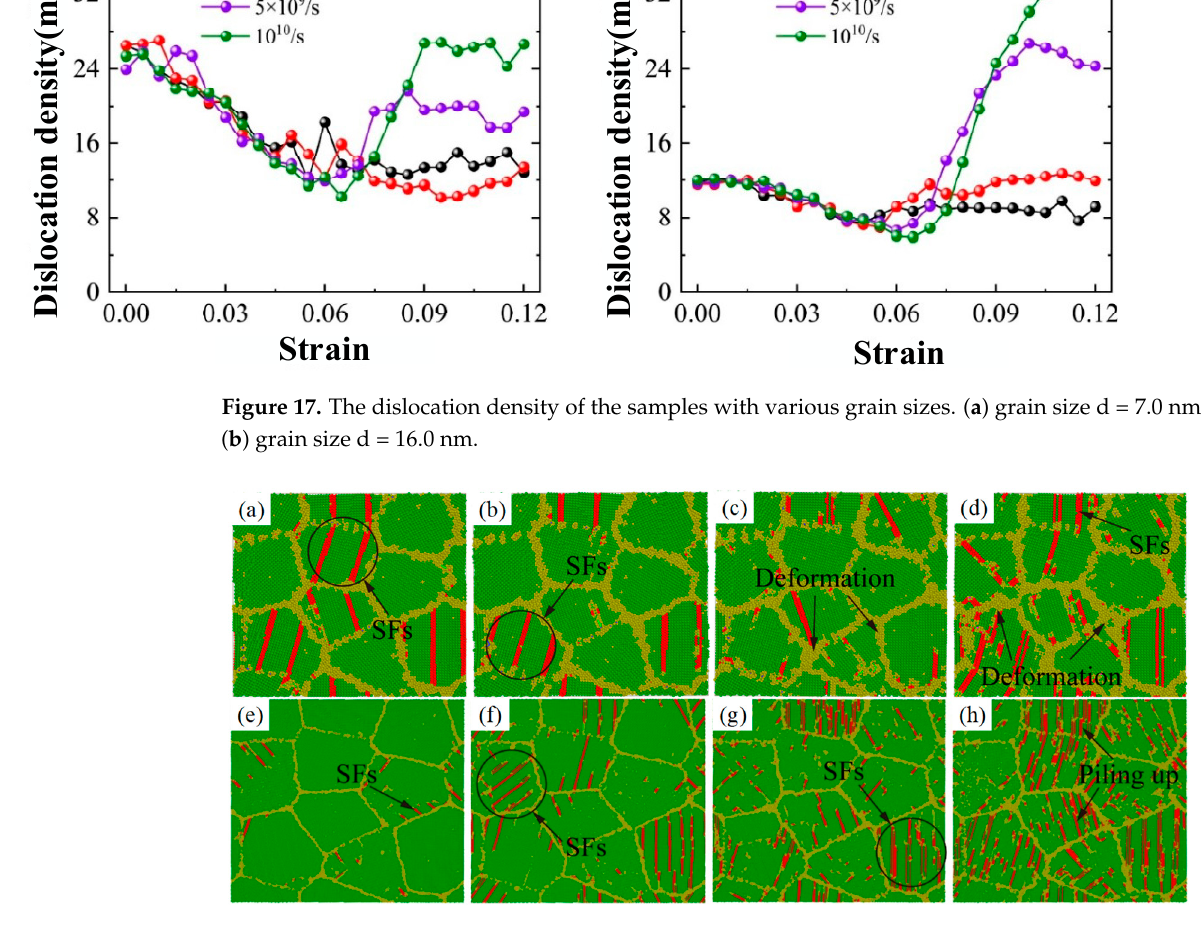
Figure 19. The dislocation lines of the sample with grain size d = 16.0 nm at ε = 12% under different strain rates loading. ( a ) 5 × 10 8 s − 1 , ( b ) 10 9 s − 1 , ( c ) 5 × 10 9 s − 1 , ( d ) 10 10 s − 1 . For polycrystalline Al-Mg alloy model, the yield strength increases with the increas- ing grain size. The proportion of GB atoms influences the dislocation density. The gener- ation of dislocation decreases the yield strength in small grain size. The plastic defor- mation is dominated by grain boundary sliding in the small grain size, while it is domi- nated by dislocation slip in the large grain size. The nucleation and propagation of dislo- cation increase the yield strength at higher strain rate loading process. In addition, the strain rate corresponds to the boundary conditions of the distribution of stress on the spacecraft surface. Large pressure on the surface means a high strain rate of samples. Those results can understand the mechanism of structure failure under hyperthermal pressure condition. 4. Conclusions In summary, the metallic deformation and failure process is investigated systemati- cally via macro-micro simulations (GKUA and MD) methods. The results obtained from the MD simulations are well consistent with those from the GKUA method. The crack propagation can be separated into three stages for a pristine aluminum model with an